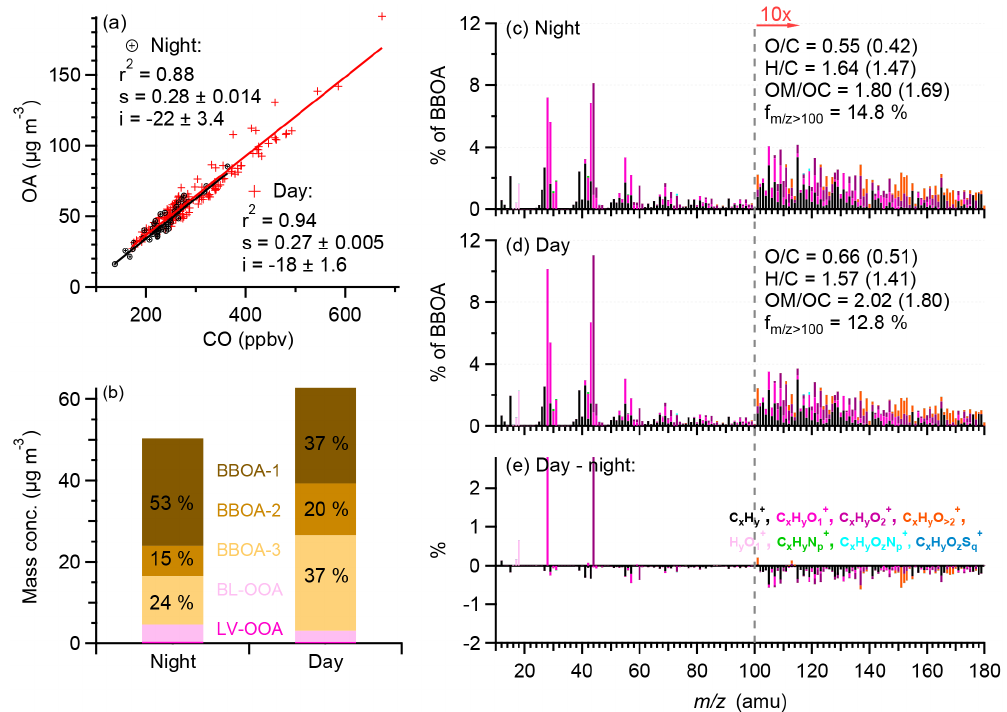
Figure 9. (a) OA vs. CO during 14 August at 20:00 to 16 August at 09:00PDT with nighttime-transported plumes illustrated as black circles and daytime-transported plumes as red crosses. The orthogonal distance regression (ODR) results for the two plume types are shown with the 1 σ uncertainties reported for the fit slopes ( s ) and intercepts ( i ); (b) a comparison of the average concentrations of five OA factors (stacked) between the nighttime- and daytime-transported plumes. The average mass fractions of the BBOAs to total OA mass in each plume type are reported; (c) average HRMS of total BBOA for the nighttime-transported plumes; (d) average HRMS of total BBOA for the daytime- transported plumes; and (e) difference BBOA HRMS between day and night plumes. The elemental ratios of BBOA calculated with the IA method are shown in the legends of panels (c) and (d) , with those obtained using the AA method in